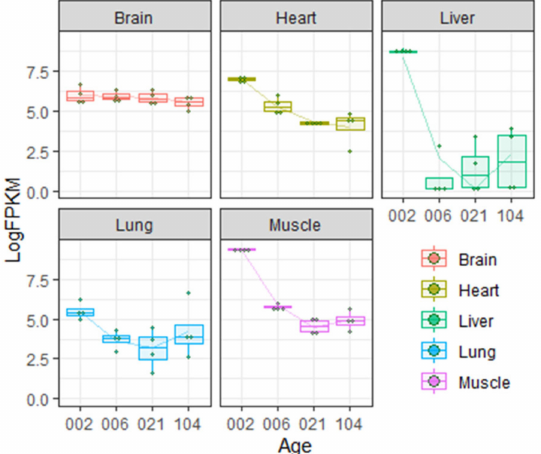
Figure 1. Insulin-like growth factor 2 (IGF-2) expression levels in different organs during postnatal development in rats according to Gene Expression Omnibus data repository [57,58]. Age is given in days. LogFPKM—logarithm of FPKM (fragments per kilobase of exon model per million reads mapped)